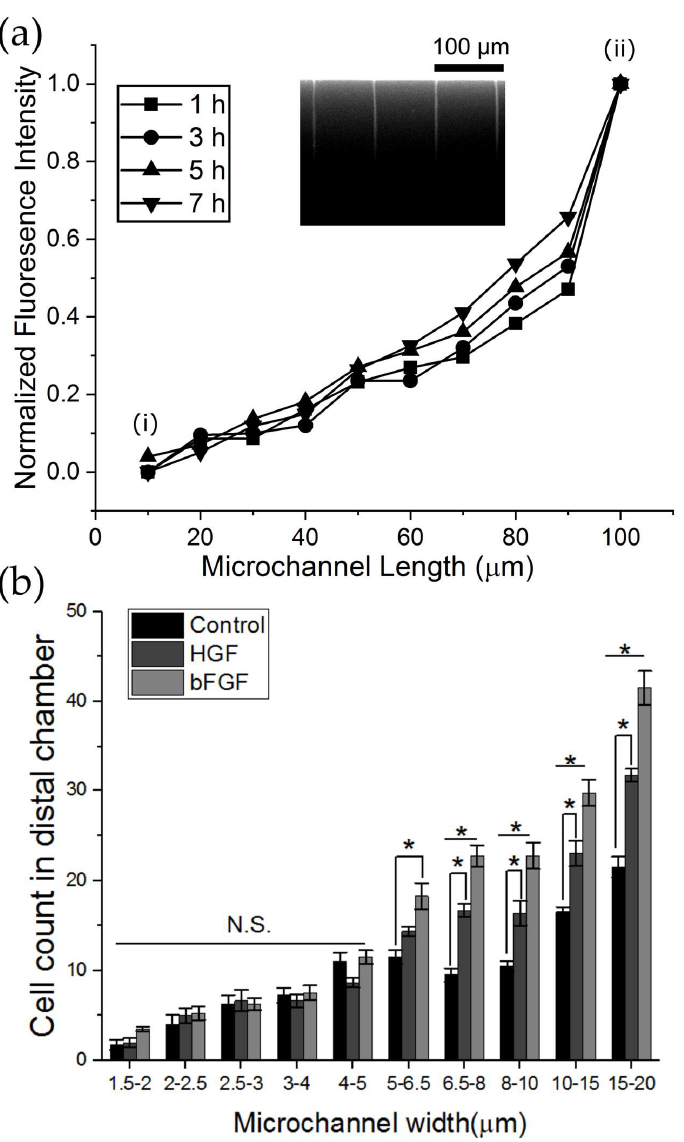
Figure 7. Effect of bFGF and HGF on myoblast migration across microchannels. ( a ) Normalized mean fluorescence intensity of FITC-conjugated dextran (molecular weight = 40,000 kDA) as a function of microchannel length at different time points. (i) Denotes the boundary of the proximal chamber or cell seeding chamber. (ii) Denotes the boundary of the distal chamber or migration chamber where FITC was introduced. Inset displays a representative image of 4 microchannels (width = 1.5 µm) at the 4 h time point which demonstrates the generation of a gradient of FITC molecules from distal (top) to proximal chamber (bottom). ( b )The multi-width device (1.5–20 µm) with constant length of 100 µm was used to assess myoblast migration across microchannels in response to a chemoattractive gradient induced by either 11 ng/mL HGF or 11 ng/mL bFGF introduced into the distal chamber. Cell counts are expressed as the number of cell crossings into the distal chamber across binned channel widths. Each bin consists of 6 microchannels per width for a total of 12 microchannels. To determine statistically significant differences in the cell count between growth factor treatment and control for a given microchannel size range a one-way ANOVA with a post hoc Tukey test was performed. Black asterisks are used to denote statistically significant differences (*p < 0.05) and error bars represent standard error of the mean (SEM).